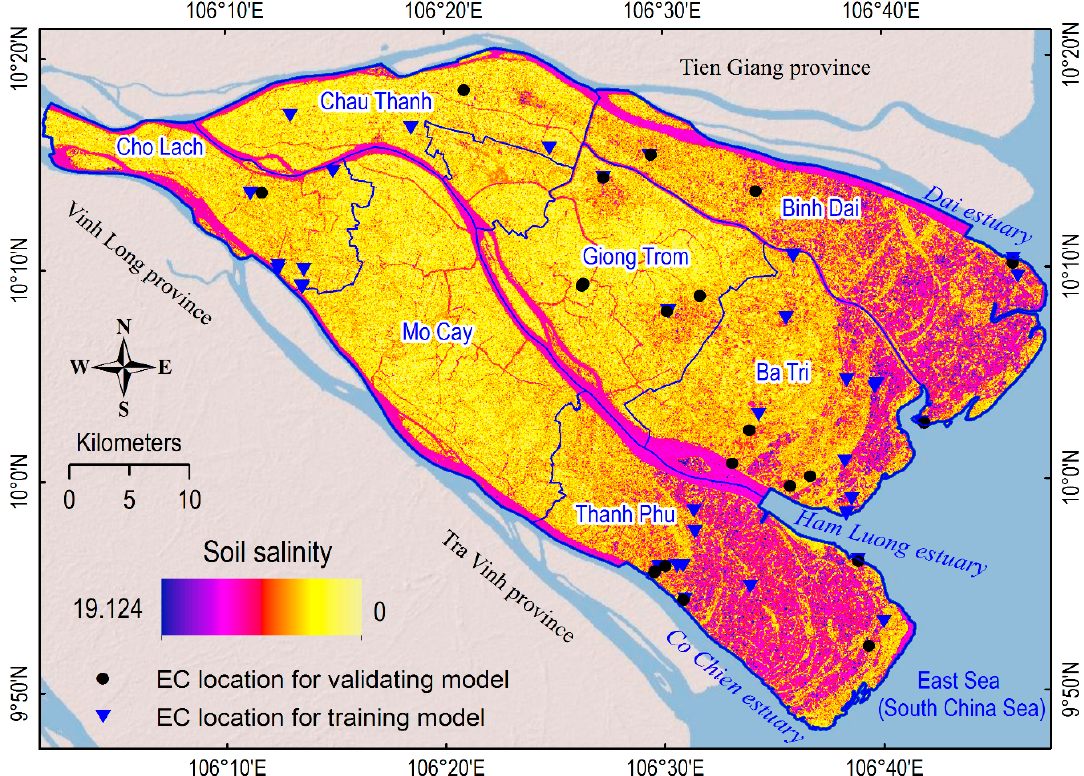
Figure 6. Soil salinity map for the Ben Tre province using the Gaussian Processes (GP) model.